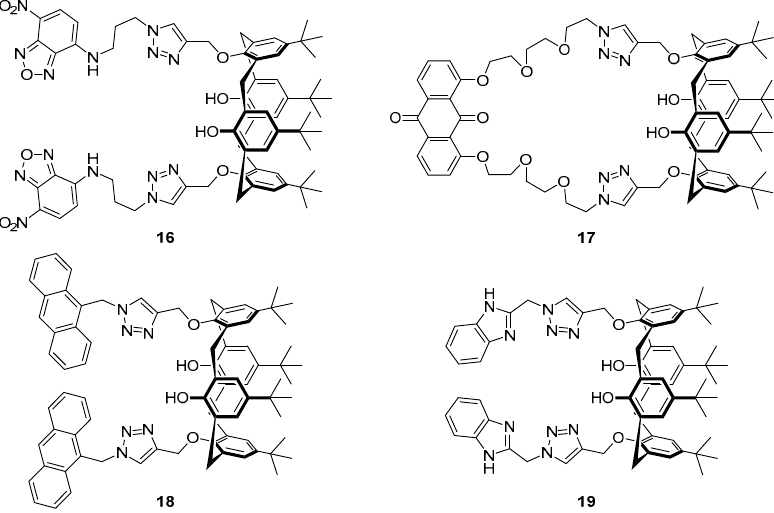
Figure 9. Benzoxadizole-functionalised calix[4]arene probe 16 responds selectively to Ag + , which triggers quenching of the free ligand emission at 527 nm and emergence of a new emission band at 576 nm; the resulting metal complex is then an effective probe for HCHO, which reduces the Ag + and regenerates the free probe 16 [89]. The anthraquinone-functionalised calix[4]arene 17 responds selectively to Ca 2+ with enhanced fluorescence emission at 510 nm, and the resulting 17 ·Ca 2+ complex then functions as a turn-off probe for fluoride [90]. Triazolyl-anthracene derivative 18 is a turn-off probe for Co 2+ [91], while the structurally related benzimidazole probe 19 binds Cu 2+ and reports this with a ratiometric fluorescence response (via changes in emissions at 311 and 380 nm) [92]. The anthraquinone/calix[4]arene derivative 17 incorporating a similar bis-triazole moiety has been reported by Zhan et al. [90]. Selective binding of sensor 17 to Ca 2+ was achieved over a variety of other cations and yielded a significant increase in the fluorescence emission at 510 nm. Job’s plot, 1 H-NMR and MS experiments confirmed the formation of a 1:1 complex, with Ca 2+ coordinating to the triazole nitrogens, an interaction facilitated by the flexible ether linkers. This coordination results in disruption of PET from the triazole to the anthraquinone fluorophore, leading to the observed fluorescence increase after Ca 2+ binding. Furthermore, the 17 ·Ca 2+ complex was found to be a selective sensor for F − over other halides, with the addition of F − leading to fluorescence quenching and revival of the original emission profile of 17 via displacement of the bound Ca 2+ to form CaF 2 . Calix[4]arene probe 18 (Figure 9), functionalised with anthracene fluorophores via triazole linkers, has been reported by Mummidivarapu et al. for sensing Co 2+ [91]. This probe was found to be selective for Co 2+ over a variety of cations tested and gave a 5-fold decrease of the 417 nm emission band with a calculated detection limit of 0.92 µM. Complexation of 18 with Co 2+ formed a 1:1 complex, confirmed by Job’s plot and MS analysis. The binding mode was determined by 1 H-NMR titration and DFT calculations which revealed that the triazole plays an important role in coordination of the Co 2+ , which binds to the triazole N 3 nitrogen and the four oxygens of the calix[4]arene. The Rao group reported benzimidazole-triazole substituted calix[4]arene 19 (Figure 9) which functions as an ‘off-on-off’ probe dependent on the concentration of Cu 2+ [92]. This system was shown to be selective for Cu 2+ via the formation of 1:1 and 2:1 Cu 2+ : 19 complexes and displayed no significant change in competition experiments with the other cations tested. DFT calculations suggested that in both complexes, a Cu 2+ ion is coordinated to the triazole N 1 nitrogens and benzimidazole nitrogens, while in the 2:1 complex, the second Cu 2+ binds to the triazole and calix[4]arene oxygens in an analogous manner to that seen in the 18 ·Co 2+ complex. Probe 19 gives a ratiometric fluorescence response to Cu 2+ , with the addition of up to three equivalents leading to quenching of the original emission maximum at 311 nm along with the appearance of an excimer emission band at 380 nm.